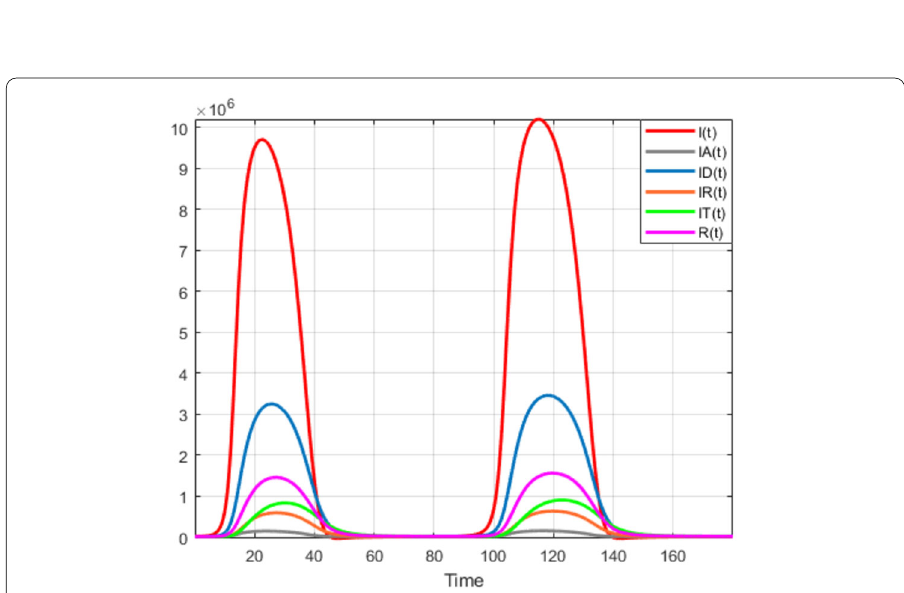
Figure 28 Numerical visualization of COVID-19 model for α =